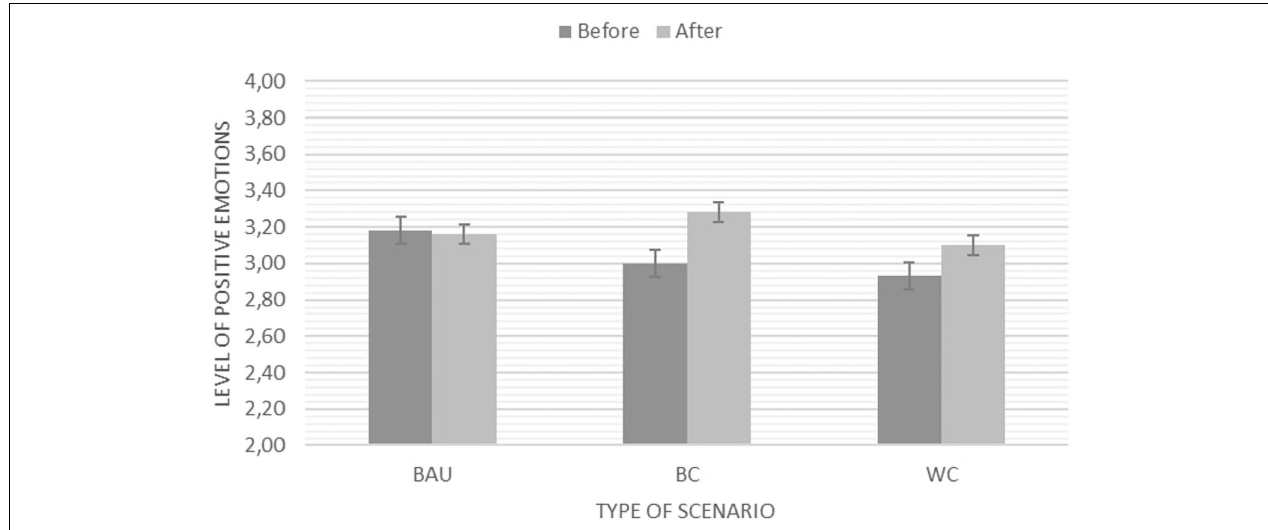
FIGURE 8 | Significant main effect and interaction for positive emotions before and after engaging with one of the three scenarios (BAU, Business as Usual; BC, Best Case Scenario; and WC, Worst Case Scenario). NB: Y -axis adapted for illustration purposes. The Likert scale ranges from 1 ( Strongly disagree ) – 5 ( Strongly agree ).